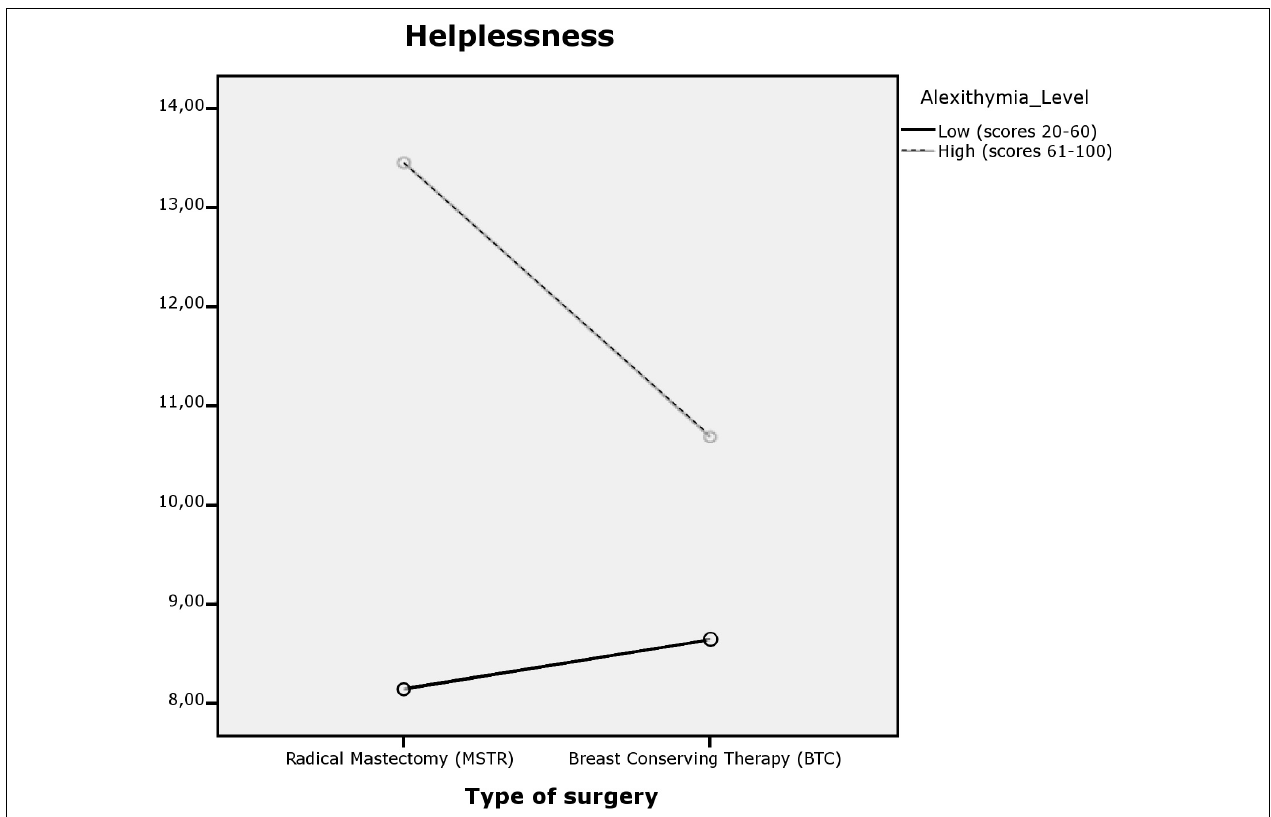
FIGURE 2 | Dual interaction graph for